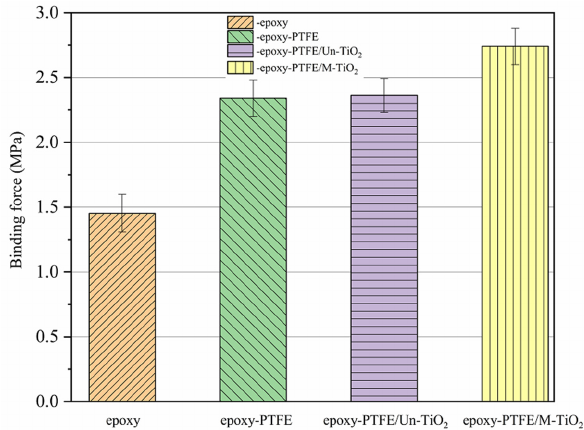
Figure 5. The results of interfacial adhesion.